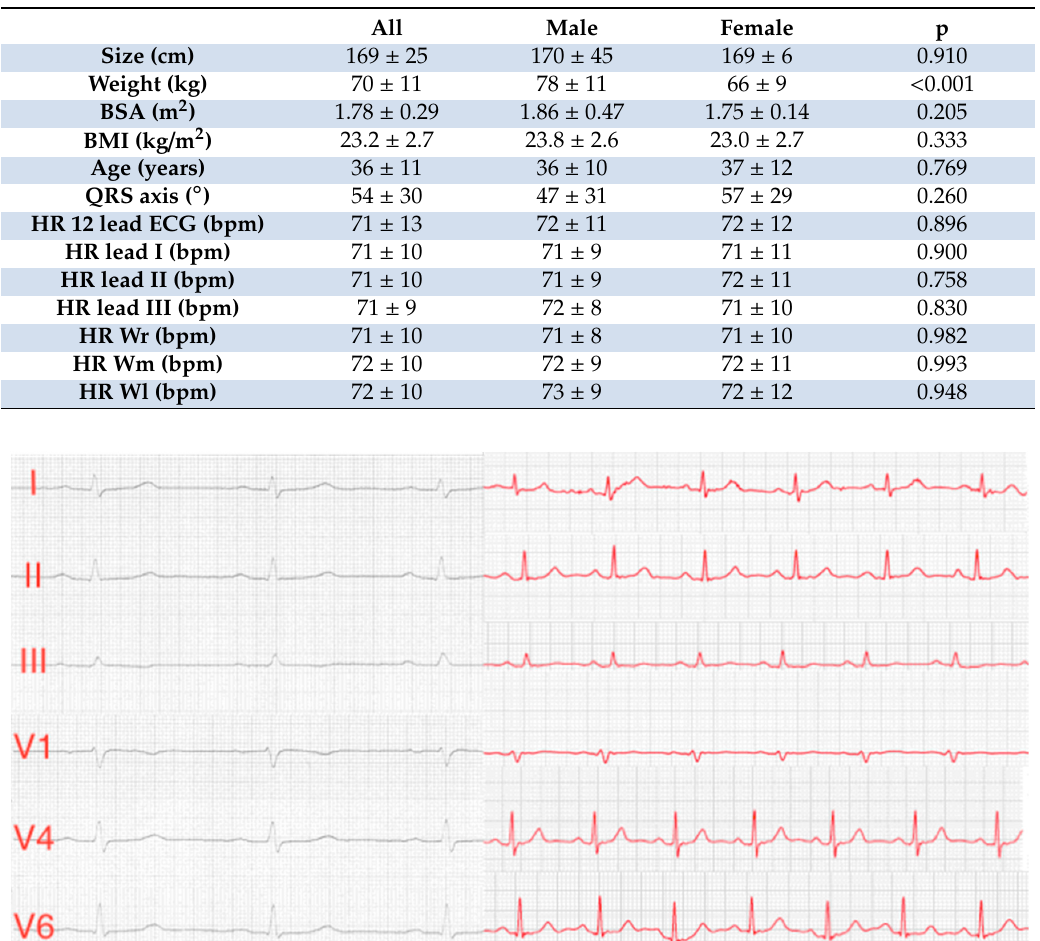
Table 1. Subject characteristics (BSA = body surface area, BMI = body mass index, HR = heart rate, lead I = Einthoven lead I, lead II = Einthoven lead II, lead III = Einthoven lead III, Wr = pseudo-unipolar recording corresponding to standard lead V1, Wm = pseudo-unipolar recording corresponding to standard lead V4, Wl = pseudo-unipolar recording corresponding to standard lead V6). P values were obtained by T-Test and ANOVA; probability limit 95%.